Question: Sum up the contents of this chart in one sentence.
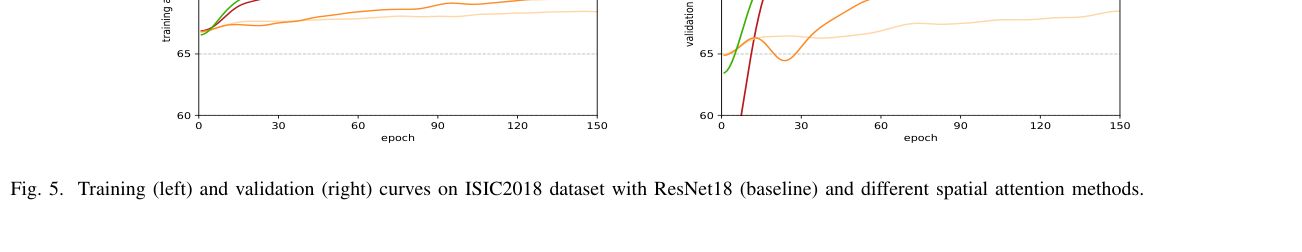
Answer: shows the training and validation curves of ResNet18 with PPCA, EA, and NL. During the training process, we can observe that PPCA achieves higher accuracy than baseline, EA, and NL, while EA and NL have lower accuracy than baseline. This suggests that using multi-scale pixel context information in a pixel-independent way with PPCA is more effective than modeling pixel context long-range dependencies with EA and NL. Performance comparison on IMED-MD dataset. Ta- ble II(Left) offers the classification results of PPCA and other comparable attention methods based on ResNet18 and ResNet50. It can be observed that our PPCA consistently improves its performance over comparable attention methods. For example, compared to SPA and NL, PPCA achieves absolute over 1.17% gains of three evaluation measures under ResNet18. The results prove the superiority of PPCA in an adaptive aggregation of multi-scale pixel context information in a pixel-independent manner. Performance comparison on Fundus